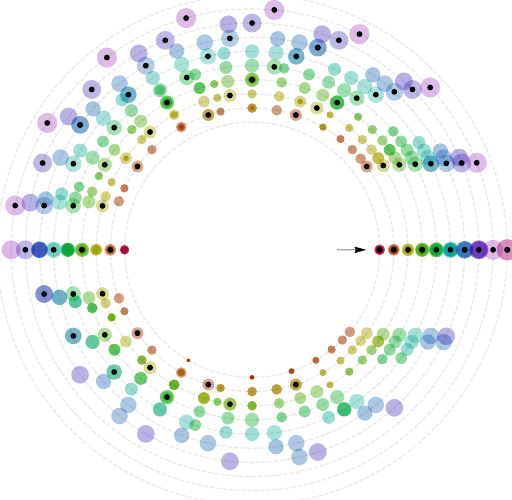
0 for all possible F associated with I 0 = 0, for each given 1